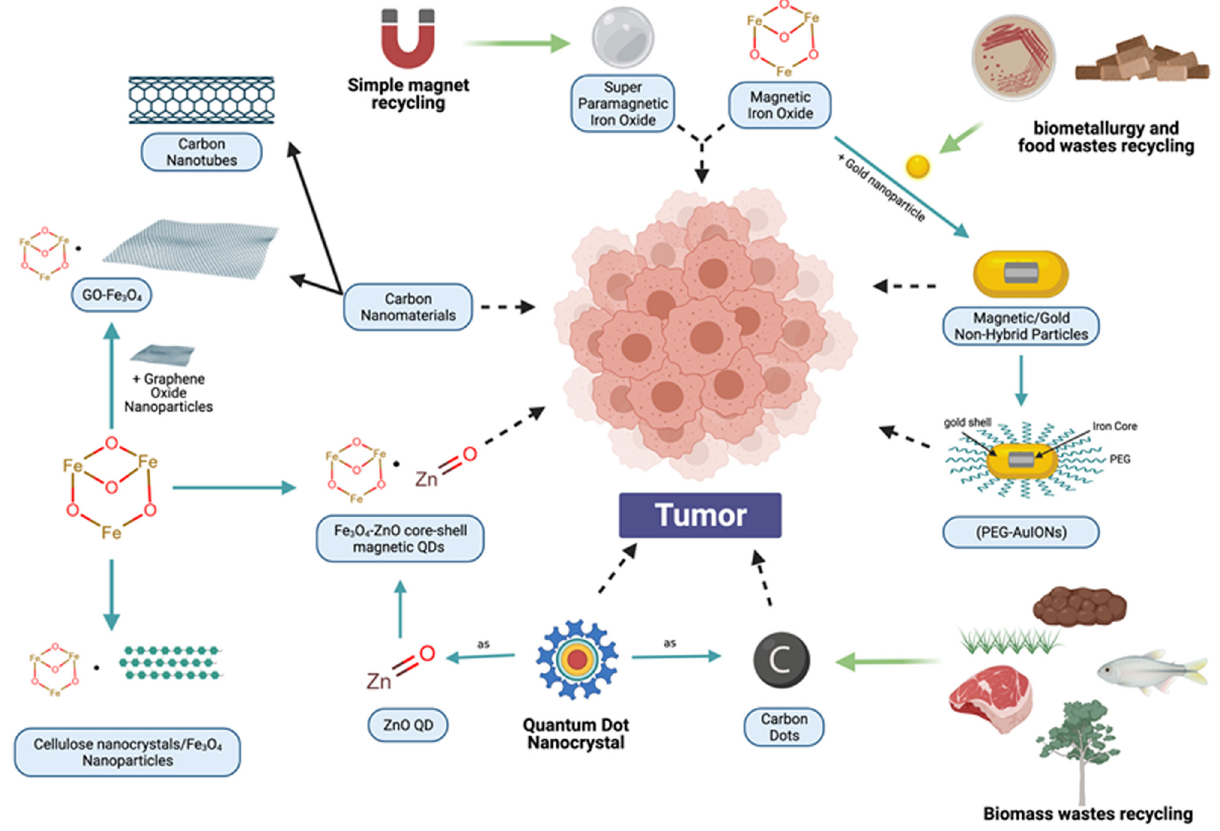
Figure 13: Schematic representation of some NPs recycled from wastes and used in MRI for the diagnosis of diseases, especially